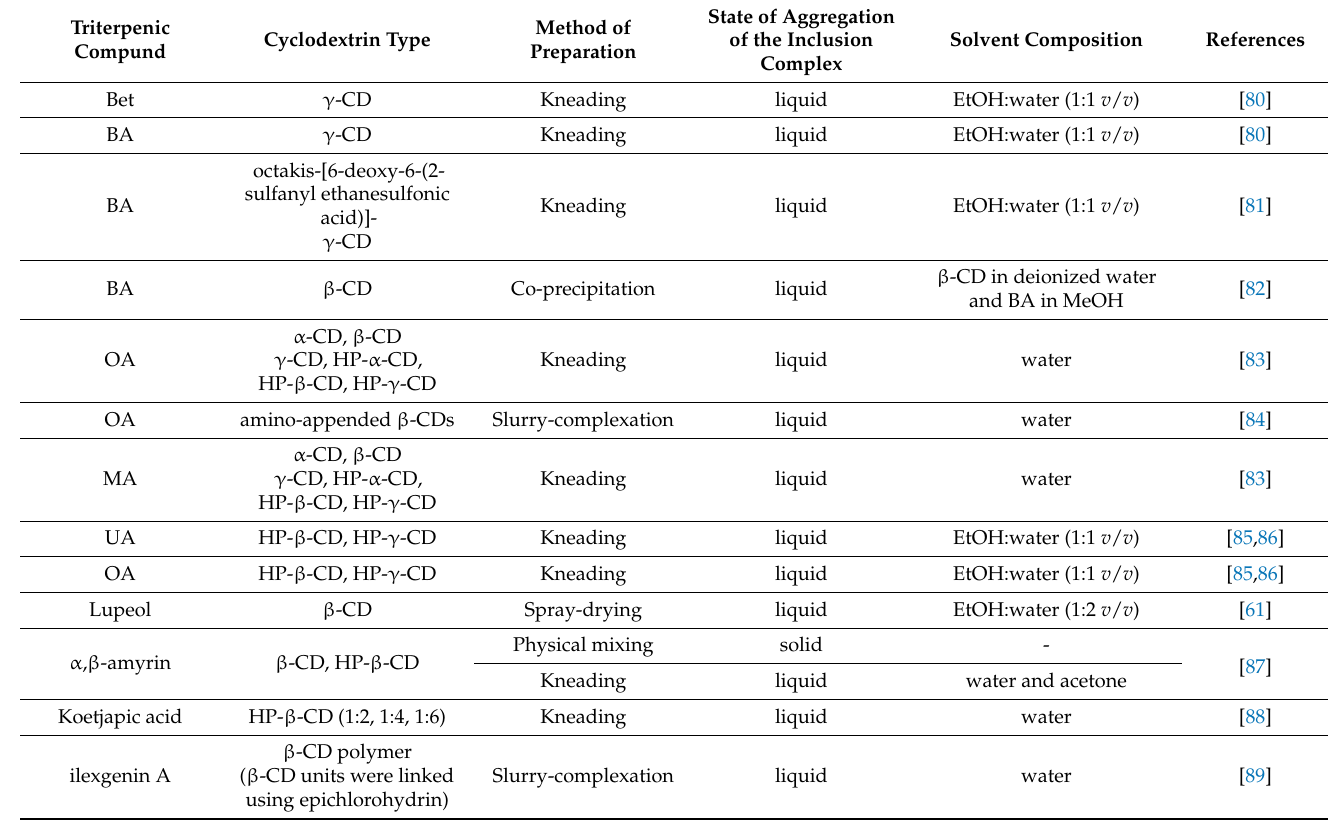
Table 3. Methods of preparation for cyclodextrin inclusion complexes with triterpenic